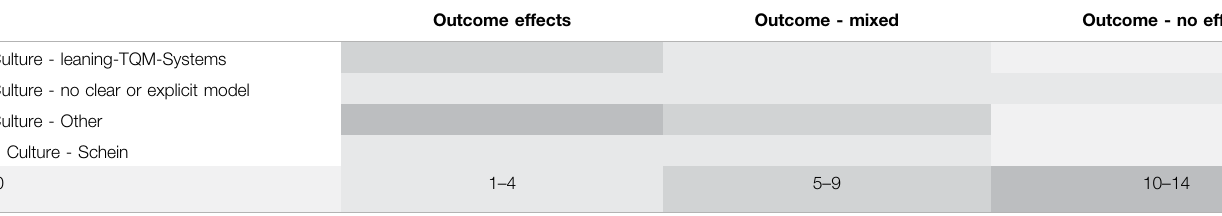
TABLE 2 | Matrix query results: Culture by